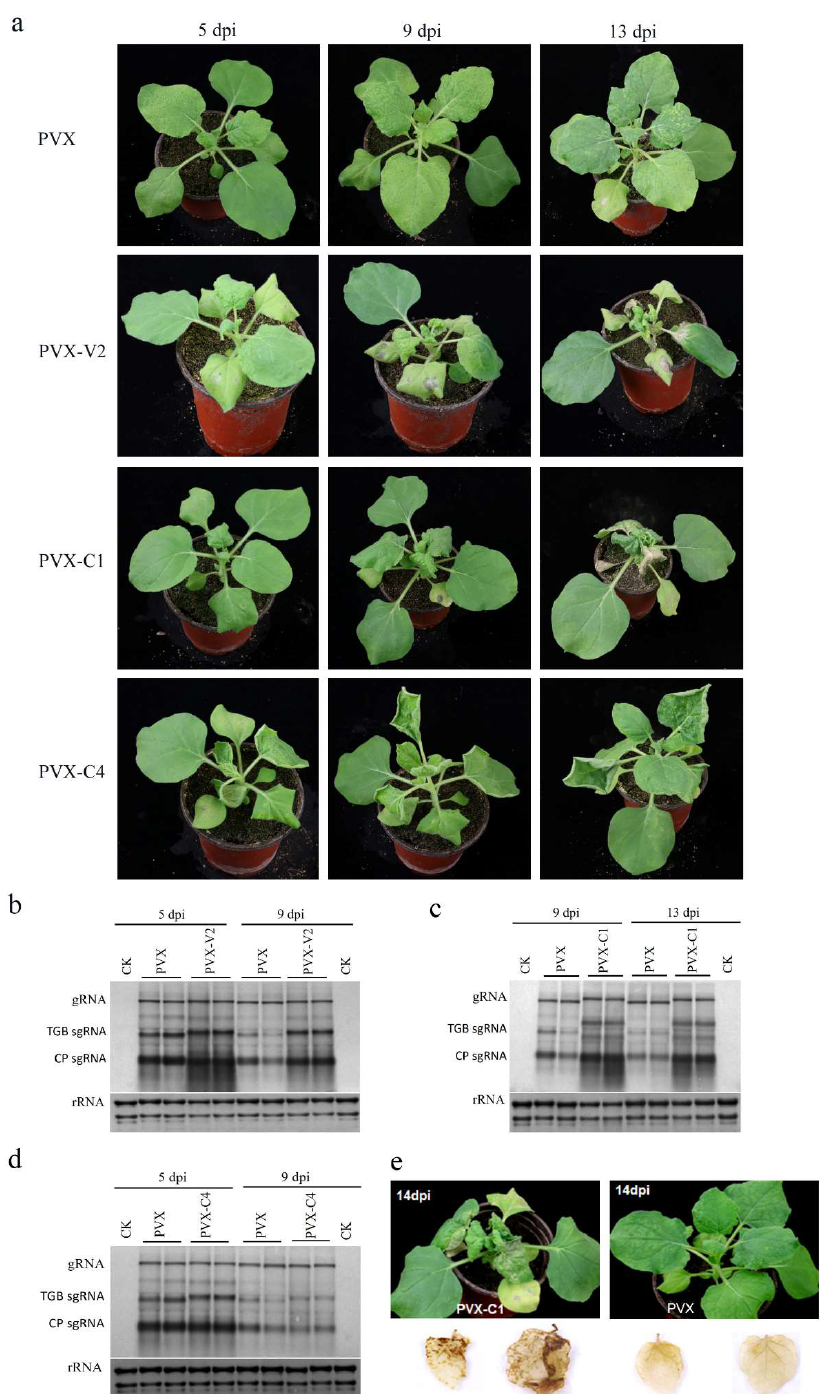
Figure 4. AGV V2 and C1 enhance pathogenicity of chimeric PVX and AGV C4 is a putative symptom determinant. ( a ) Symptoms of N. benthamiana plants inoculated with PVX, PVX-V2, PVX-C1 and PVX-C4. Symptoms were photographed at 5 dpi, 9 dpi, and 13 dpi. The images shown are representative plants out of six plants with each construct in at least three independent experiments. Northern blotting analyses of PVX-V2 ( b ), PVX-C1 ( c ), and PVX-C4 ( d ) accumulation compared with PVX. The blot shown is a representative result of three independent experiments. The probe used was specific for PVX RNA. ( e ) DAB staining for detection of H 2 O 2 accumulation in PVX-C1- and PVX-inoculated N. benthamiana plants at 14 dpi, showing the higher accumulation of H 2 O 2 in PVX-C1 inoculated leaves.